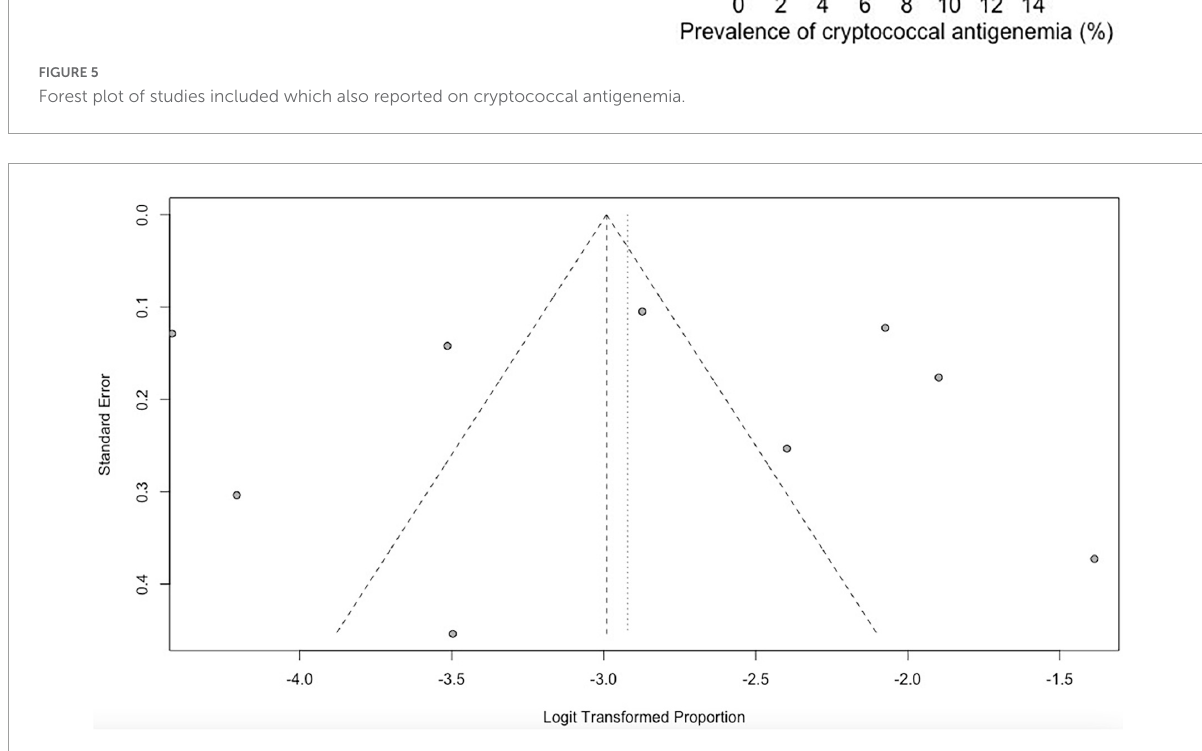
FIGURE6 Funnel plot to assess publication bias for pooled prevalence (random